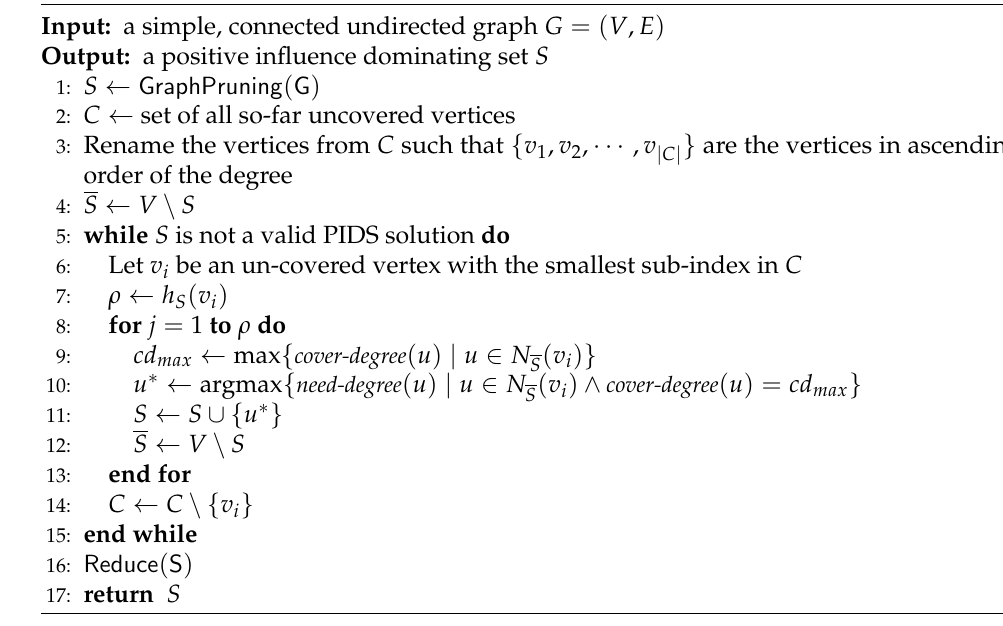
Algorithm 3 IGA-PIDS: Improved greedy algorithm for the MPIDS problem